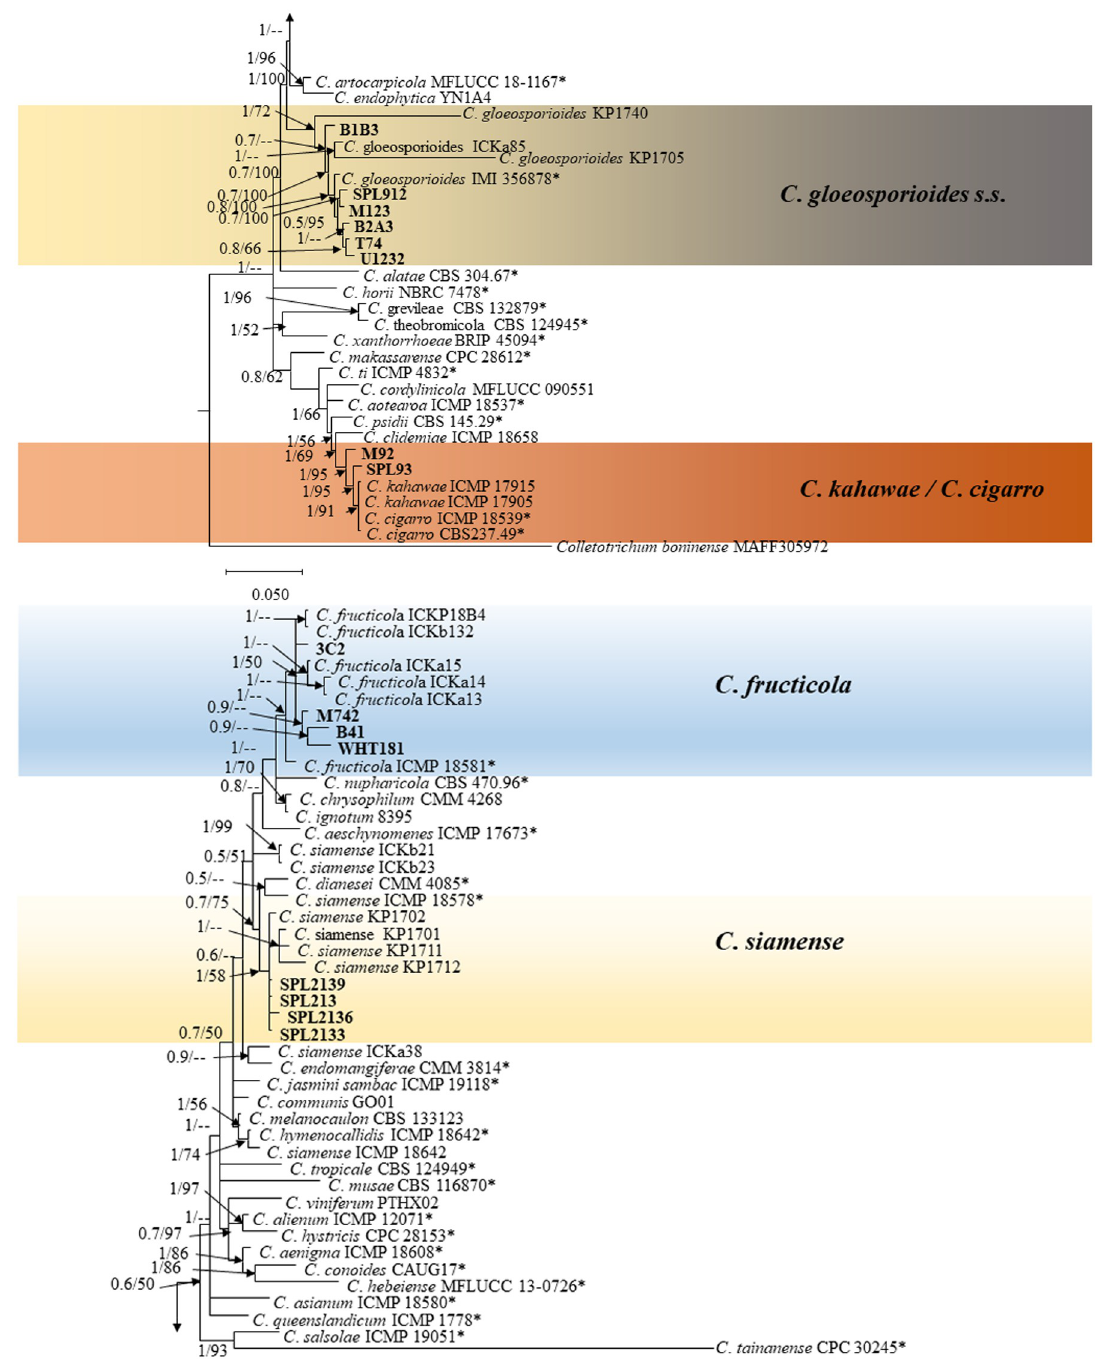
Fig 4. A Bayesian inference phylogenetic tree (50% majority consensus) of 54 isolates of the C . gloeosporioides species complex. The tree is rooted with C . boninense (MAFF305972). The tree was constructed using a concatenated data set of ITS, ACT , TUB2 , CHS-1 , and GAPDH sequences. Bayesian posterior probability (PP � 0.50) and maximum likelihood bootstrap support values (ML � 50) are shown at the nodes. � Indicates the ex-type strains. The isolates collected in this study are indicated in bold. Colored blocks indicate clades containing isolates from Atractylodes ovata in this study. The scale bar indicates 0.2 expected changes per site.